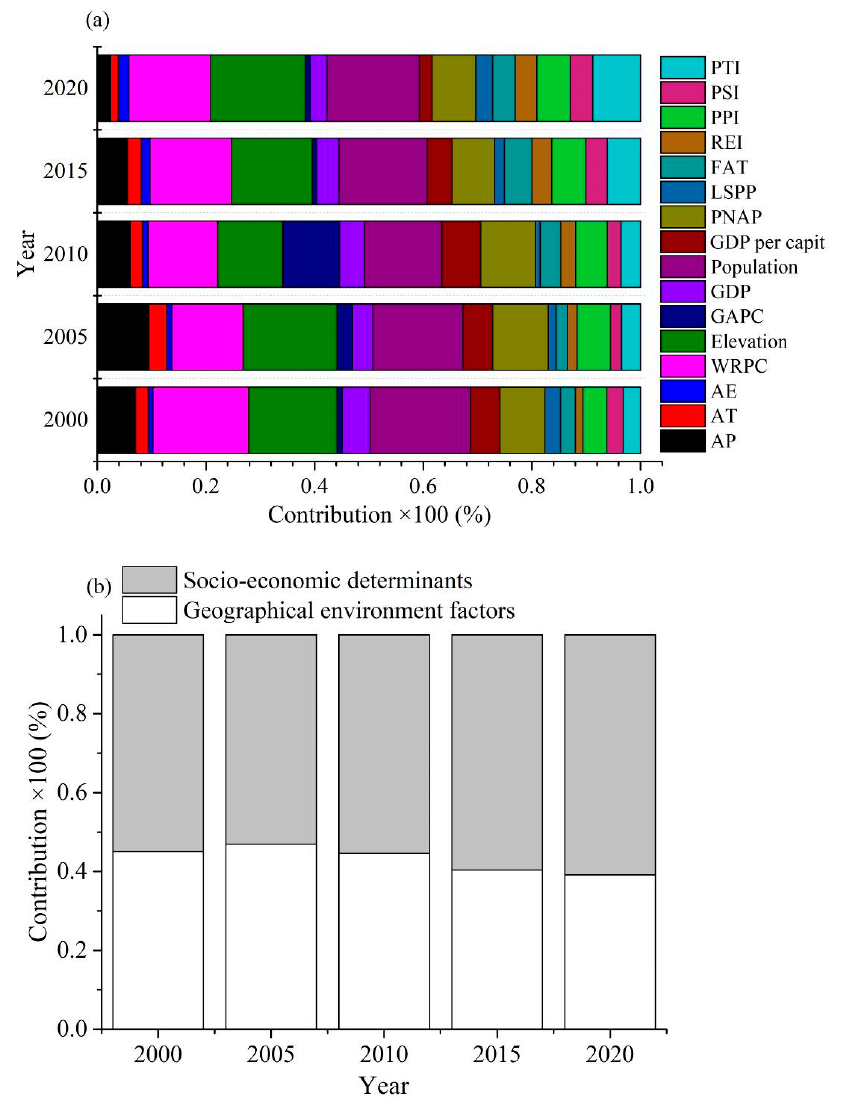
Figure 4. The contributions of socio-economic determinants and geographical environmental factors to the spatial-temporal change of green space over the past 20 years. The explanations of REI, FAT, LSPP, PNAP, GAPC, WRPC, AE, AT, AP, PTI, PSI and PPI are given in Table 1. ( a ) The contributions of all influencing factors; ( b ) The contributions of socio-economic determinants and geographical environmental